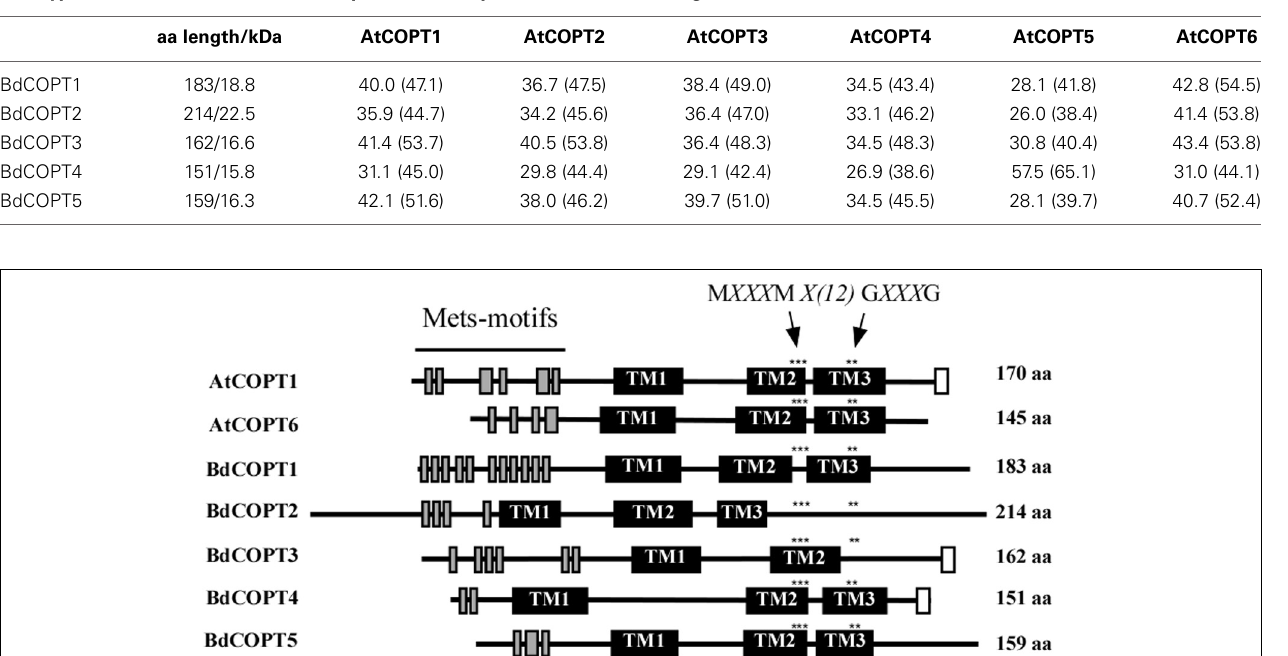
TM2, and TM3; black bars) and cysteine-rich motifs within the predicted C-terminal domain (white bars). Asterisks “ ∗∗∗ ” and “ ∗∗ ” indicate the location of conserved M XXX M and G XXX G motifs. Note that BdCOPT3 has a unique structure of two transmembrane domains and that BdCOPT3 and BdCOPT4 have cysteine-rich domains in the C-terminal